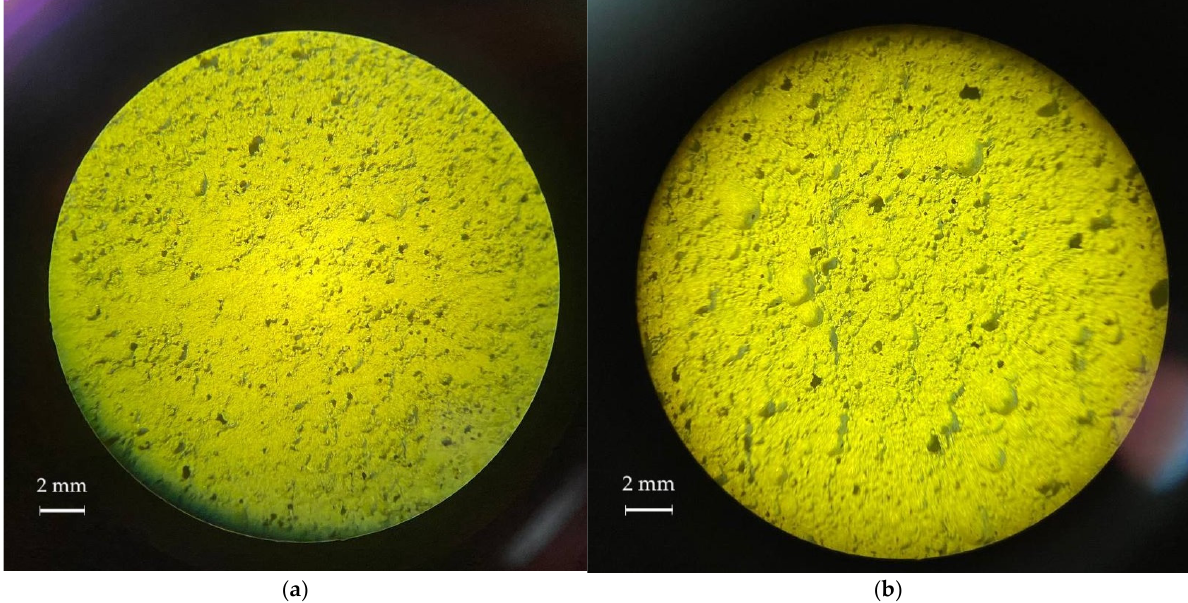
Figure 9. Structure of FFC: ( a ) control composition; ( b ) composition with 10% fly ash instead of cement (6 times magnification). cement (6 times